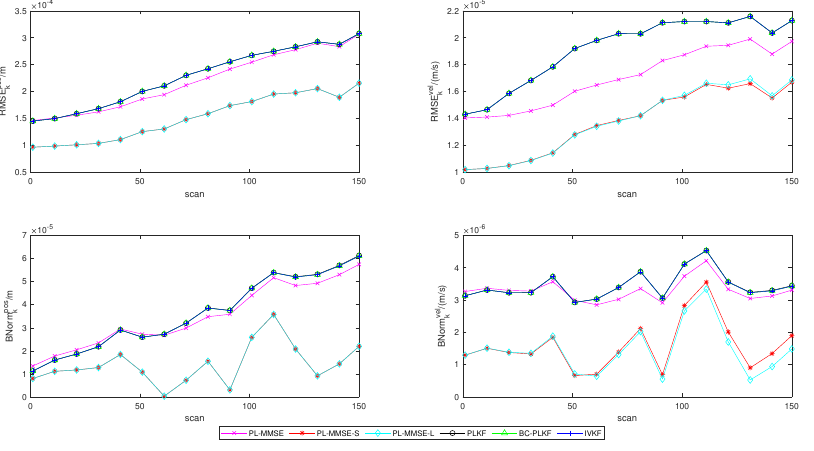
Figure 9. RMSEs, BNorms and time kT for σ θ = 7 ◦ at V = 10 − 4 m/s for the PL-MMSE, PLKF, BC- PLKF and IVKF algorithms, as well as, the proposed PL-MMSE algorithm with nonlinear constraints in the